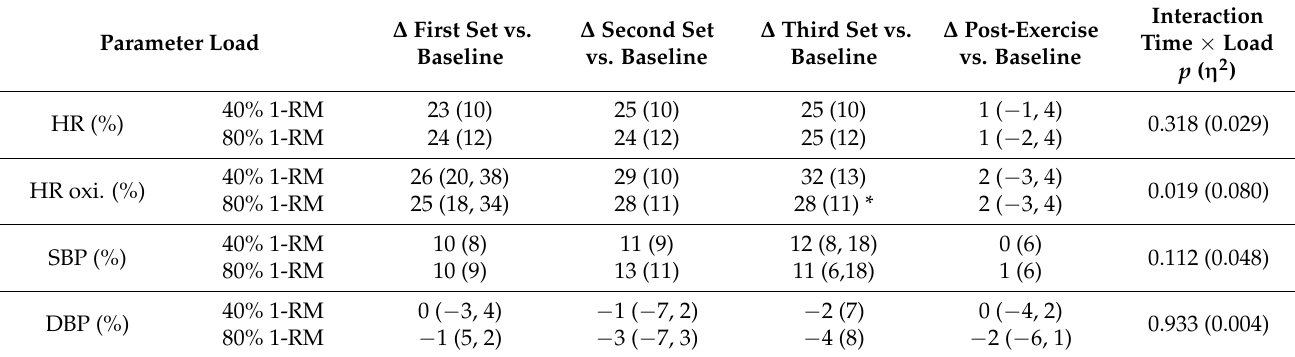
Table 3. Baseline percentage change of hemodynamic parameters during low-load (LL) resistance exercise (RE) and high load (HL)-RE. Parameter Load